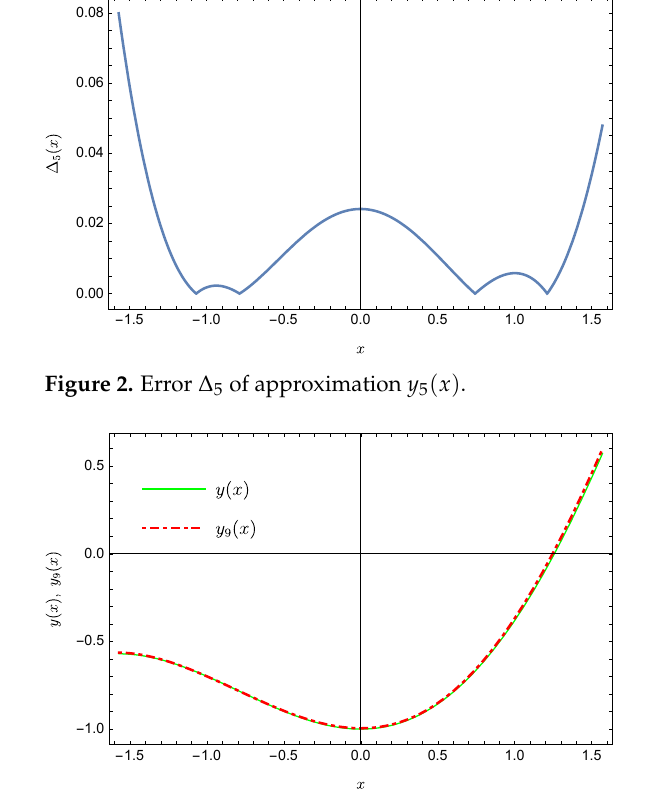
Figure 3. Exact solution and the approximate solution y 9 ( x )